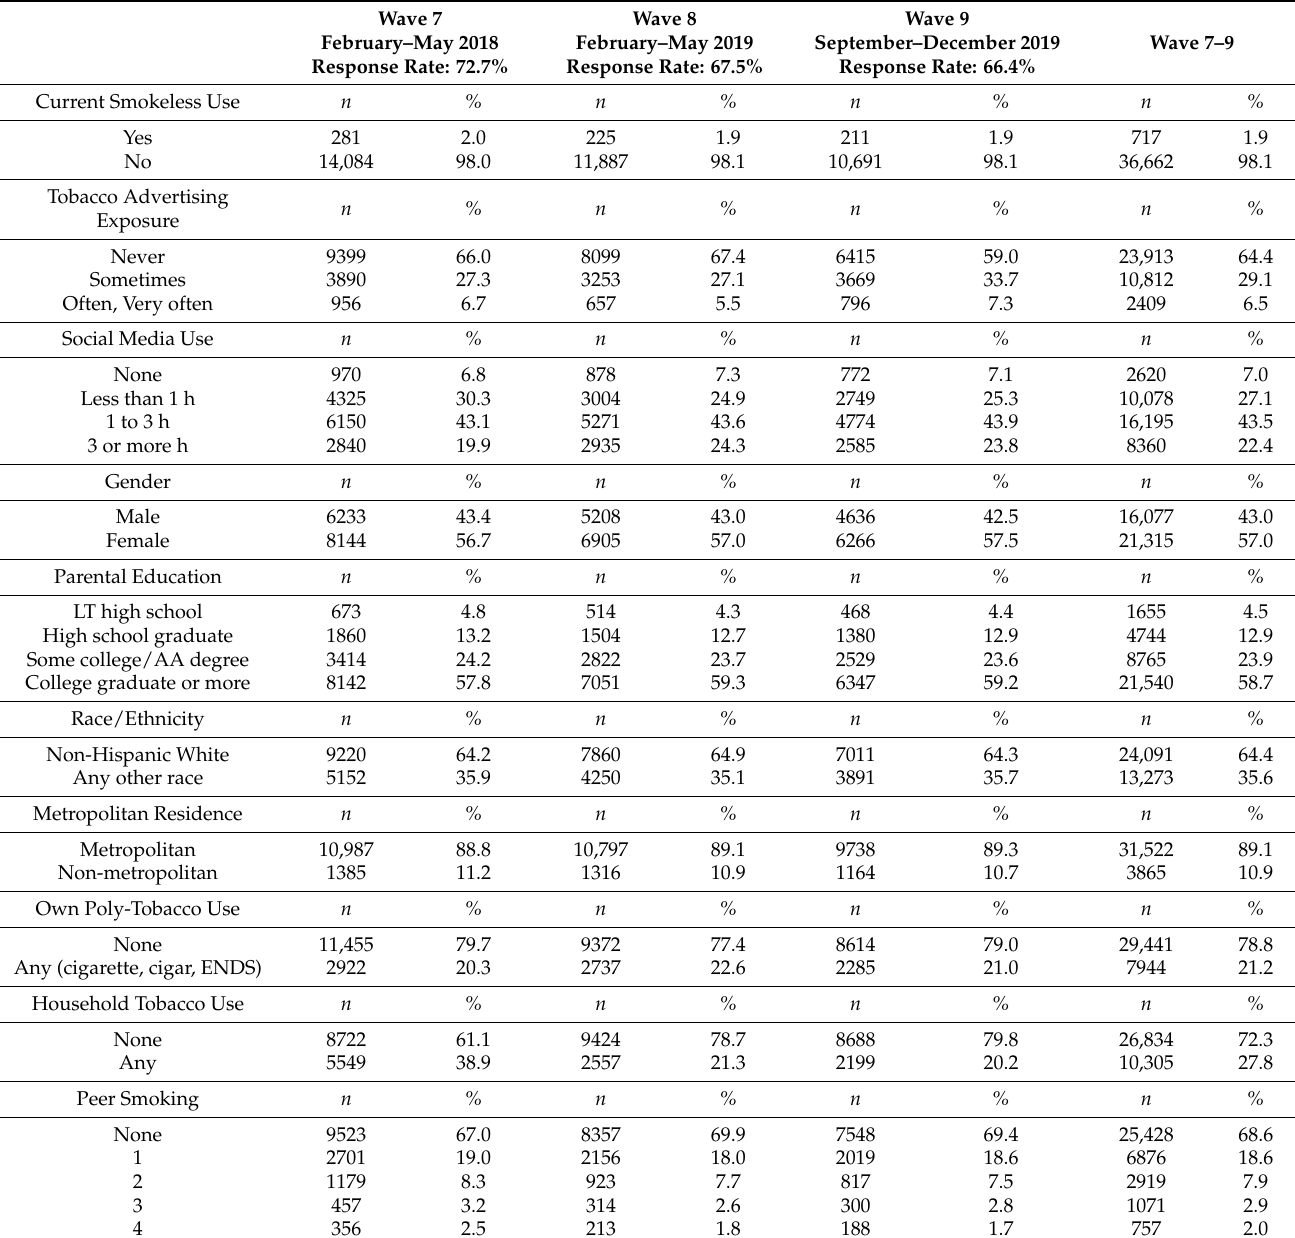
Table 1. Categorical sample characteristics across Waves 7, 8 and 9 of the national Truth Longitudinal